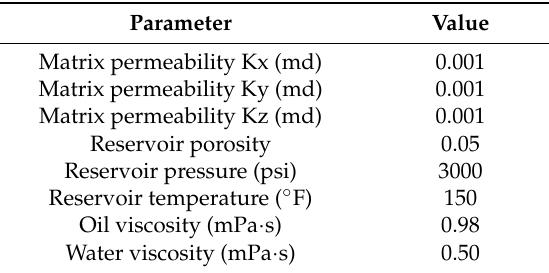
Table 1. Reservoir and Fluid Properties.